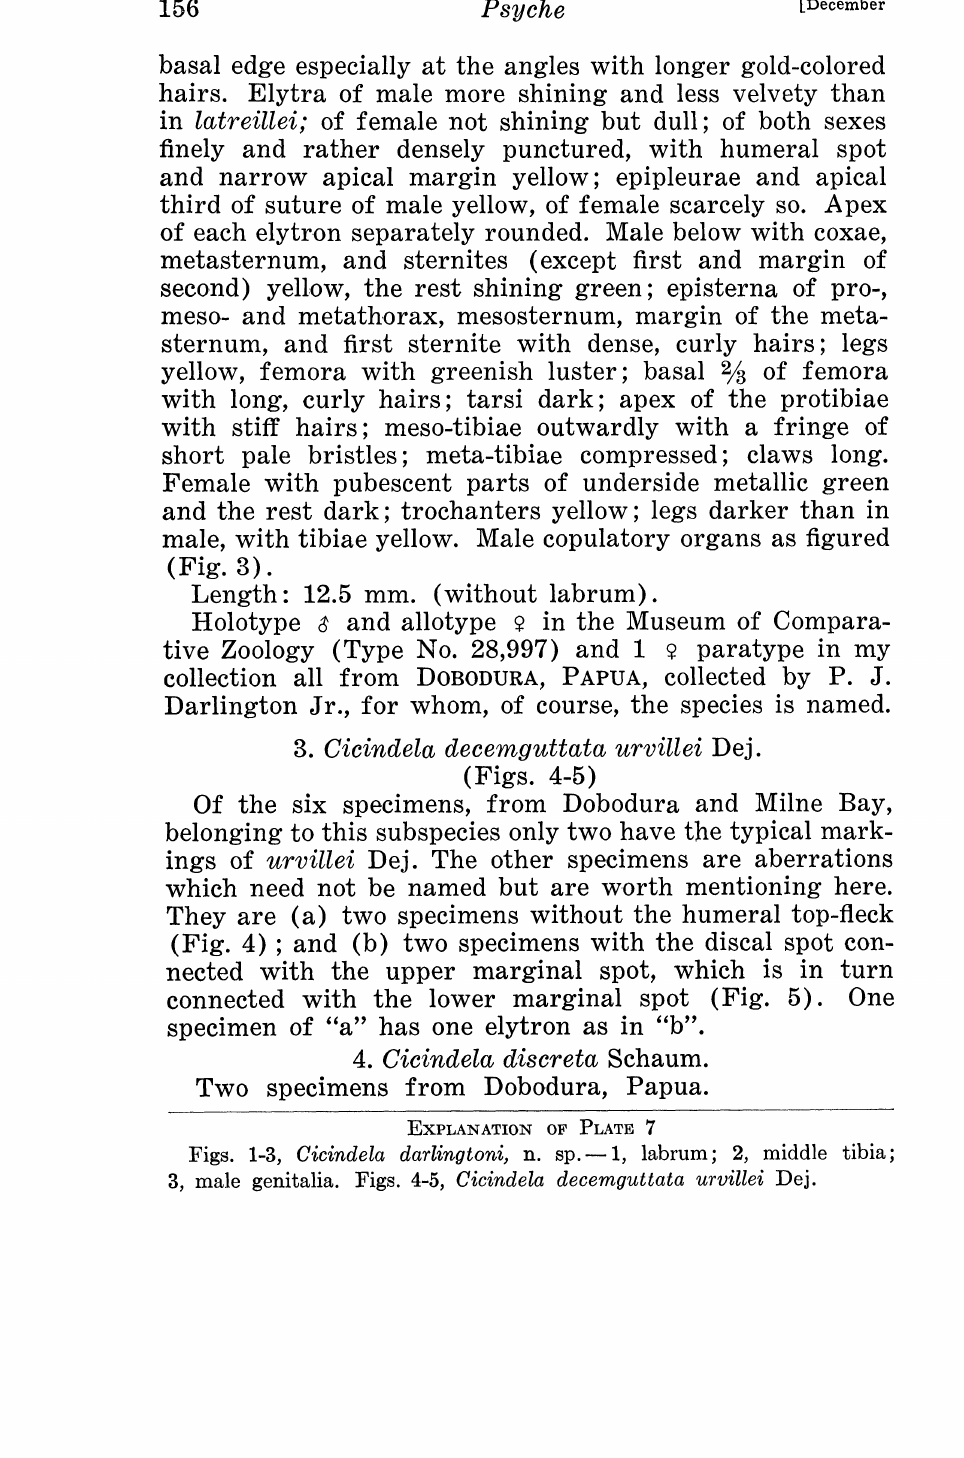
Figs. 1-3, Cicindela darlingtoni, n. sp.ml, labrum; 2, middle tibia; 3, male genitalia. Figs. 4-5, Cicindela decemguttata urvillei